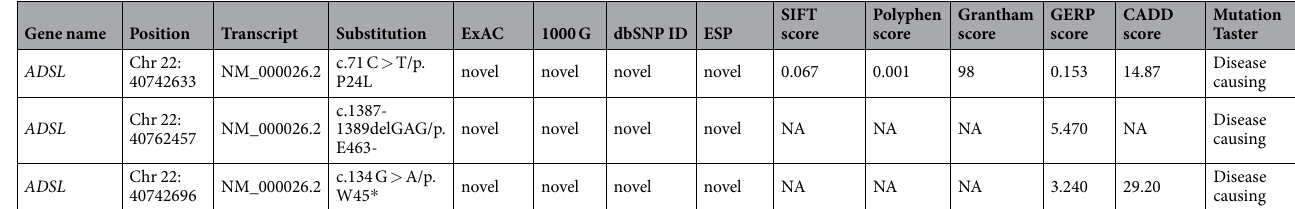
Table 2. The prediction of the identified variants in ADSL . Abbreviations: ExAC, Exome Aggregation Consortium; 1000 G, 1000 genomes; ESP, Exome Sequencing Project; NA, not